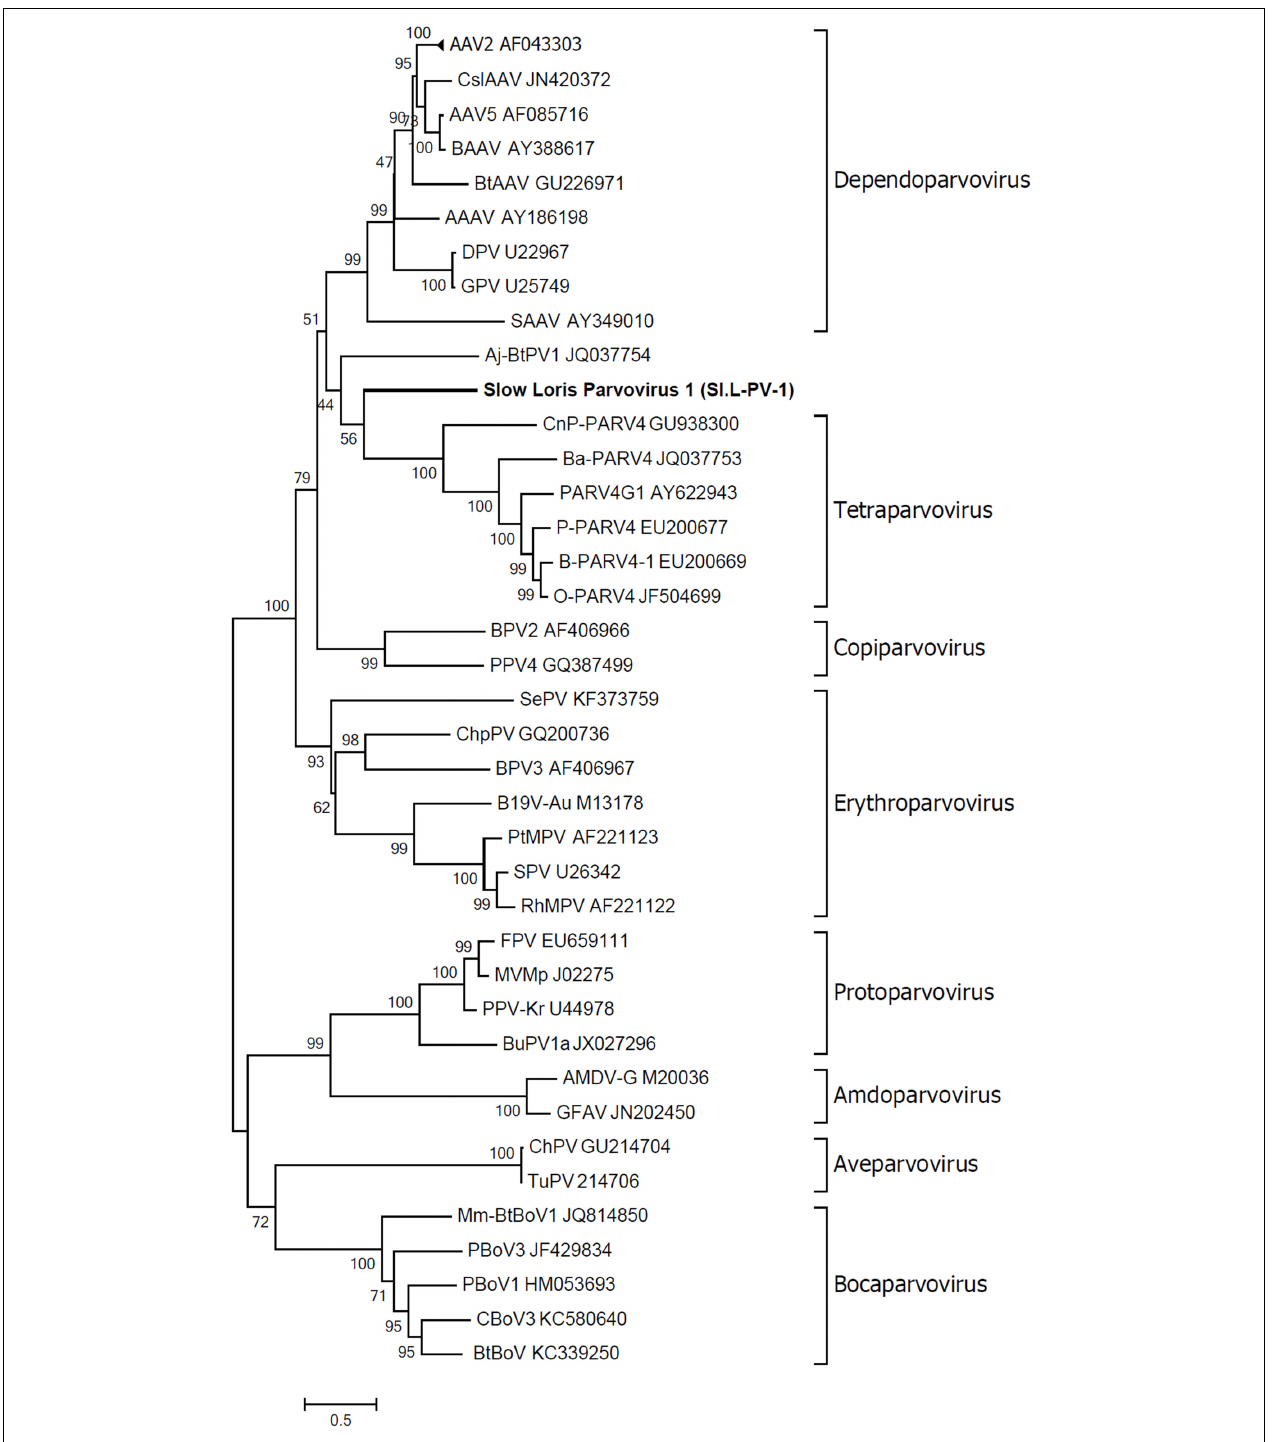
FIGURE 4 | Phylogenetic analyses of slow loris parvovirus 1 (Sl.L-PV-1). The evolutionary history of Sl.L-PV-1 and the other members of the Parvovirinae subfamily was inferred using the Maximum Likelihood method (Felsenstein, 1981) based on the rtREV + Freq model (Dimmic et al., 2002), identified as the best fitting model after the model test analysis, using MEGA6 (Tamura et al., 2013). A distance Gamma distribution was used to model evolutionary rate differences among sites ( + G, parameter =